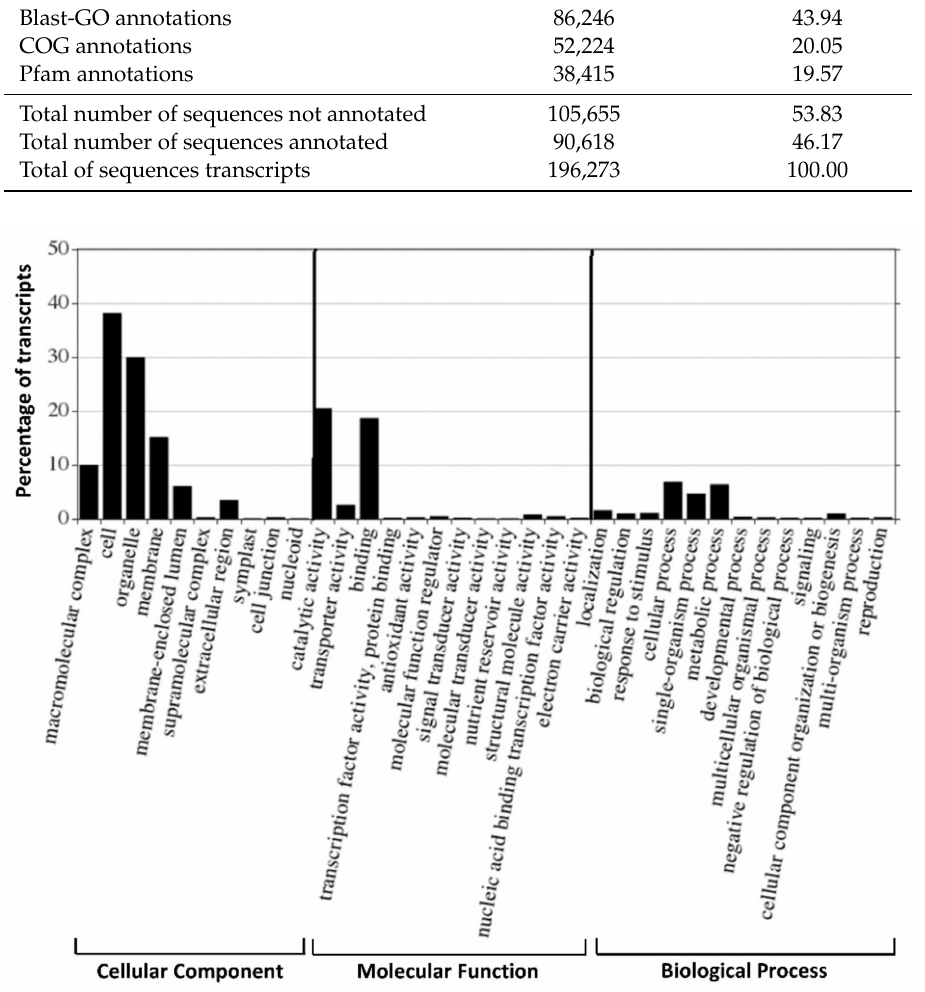
Figure 4. Gene Ontology (GO) terms of 41 functional groups of expressed transcripts from Inonotus obliquus